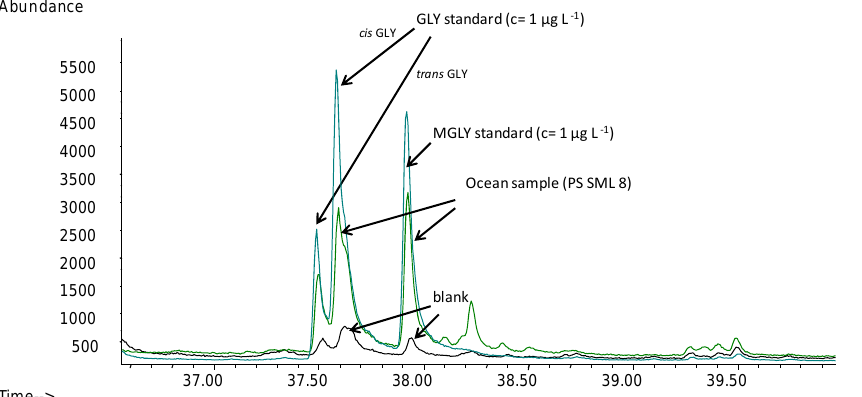
Fig. 2. SIM chromatograms of GLY and MGLY standard, ocean sample and blank (milliQ water + PFBHA), 100mL sample volume each, PFBHA was pre-cleaned over a SPE C18 cartridge.